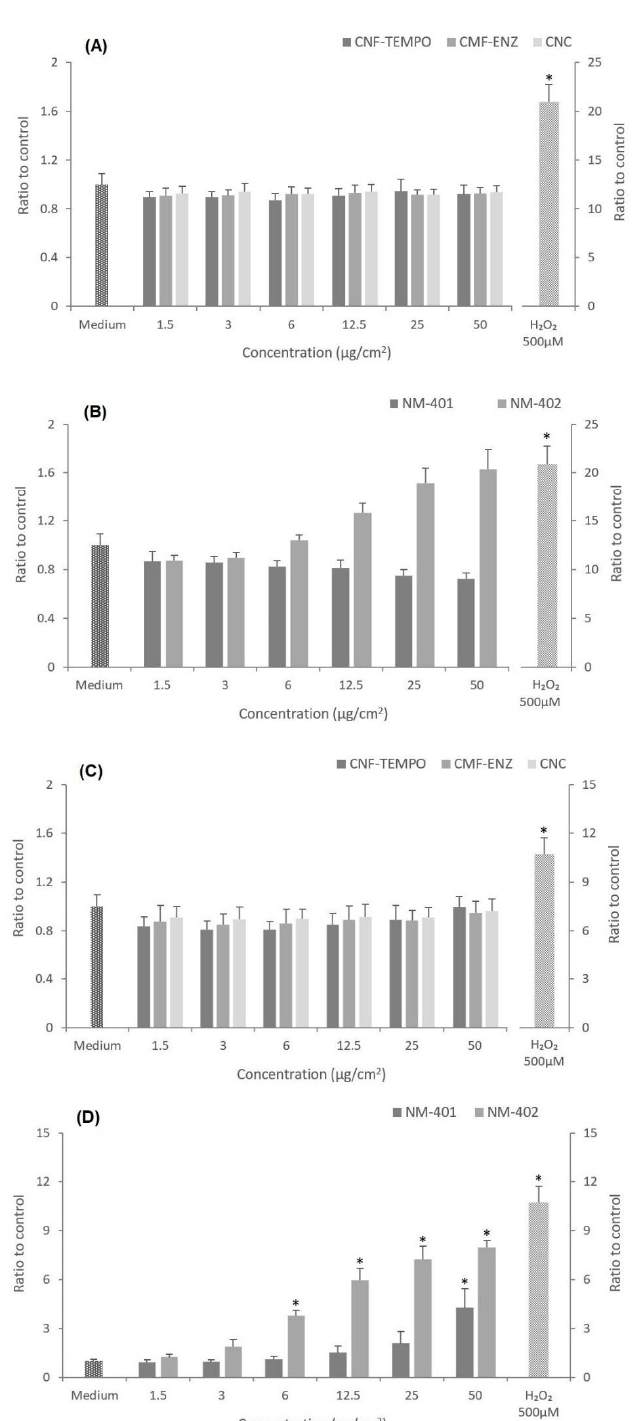
Figure 8. Intracellular reactive oxygen species (ROS) production after 1 h and 24 h exposure of A549 cells to nanocellulose and MWCNT samples under study: ( A ) 1 h exposure to CNF-TEMPO, CMF-ENZ, and CNC; ( B ) 1 h exposure to NM-401 and NM-402; ( C ) 24 h exposure to CNF-TEMPO, CMF-ENZ, and CNC; and ( D ) 24 h exposure to NM-401 and NM-402. The results are expressed as mean ± SD of three independent experiments, each carried out in triplicate. * Denotes a statistically significant difference from the control ( p <